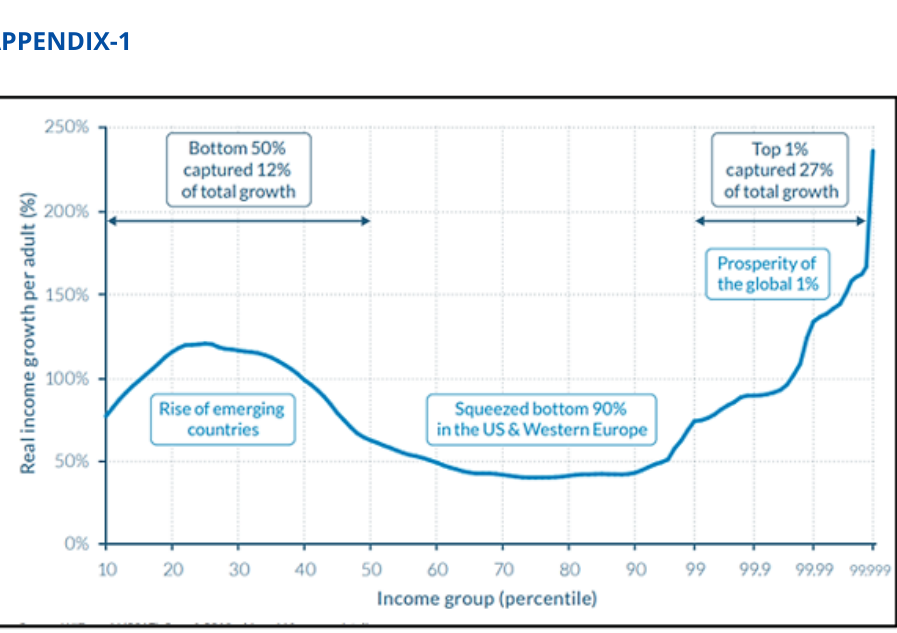
Figure A. 1: The elephant curve 1980-2016. Source: World Inequality report